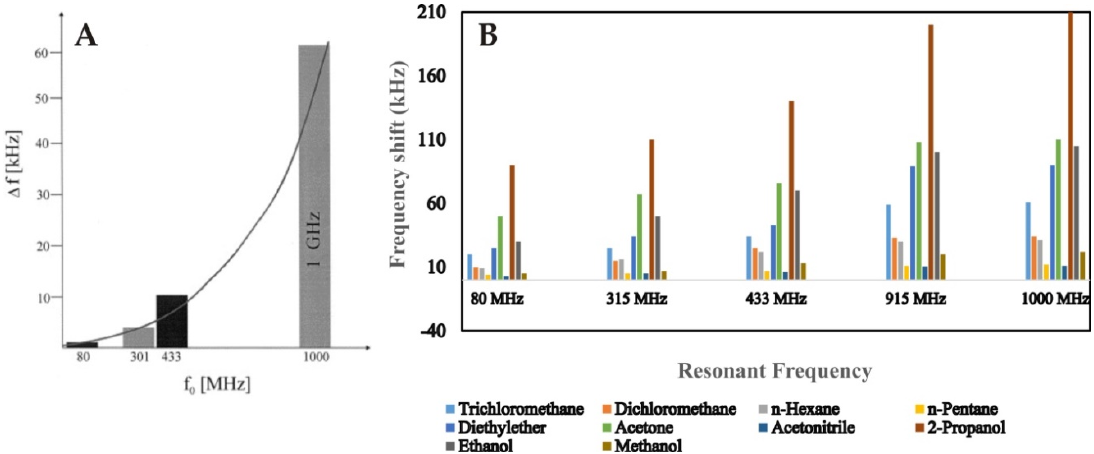
Figure 9. ( A ) Sensor responses of 80, 301, 433 and 1000 MHz SAW sensors against 1000 ppm of toluene vapors, along x -axis the f o represents fundamental resonance frequency, all the devices were coated with permethylated β -cyclodextrin linked with hexafluorobenzene having thickness 60 nm, adapted with permission from [170]. ( B ) Sensor responses of 80, 315, 433, 915 and 1000 MHz SAW sensors against 100 ppm of different vapors, all the devices were coated with ZnO-CuO-CNT nanocomposite, adapted with permission from [171]. In both figures, sensor response increases as the resonance frequency of SAW resonator increases.